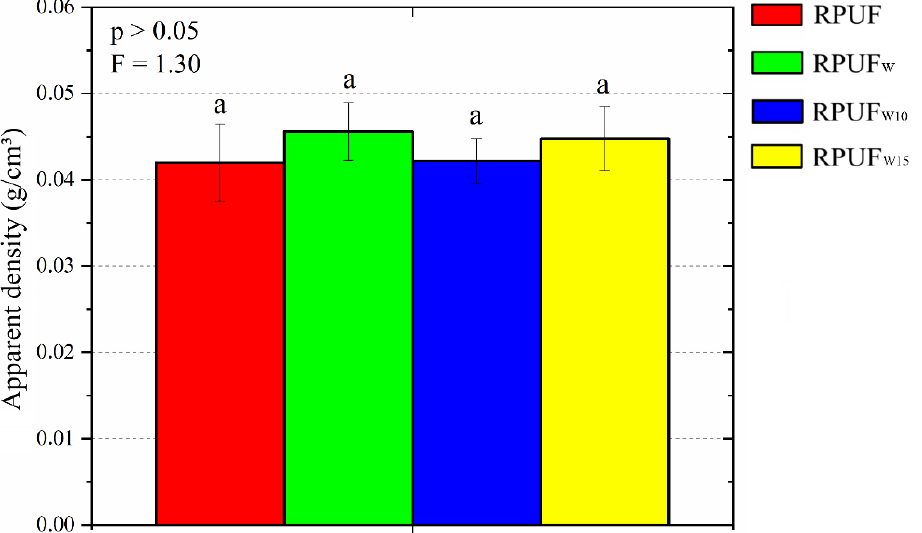
Figure 5. Apparent density of the studied RPUFs. RPUF is pure rigid polyurethane foam, RPUFw is wood flour reinforced foam, RPUF W10 is wood flour reinforced foam treated with 10% furfuryl alcohol, and RPUF W15 is wood flour reinforced foam treated with 15% furfuryl alcohol. Different letters represent statistically different means.